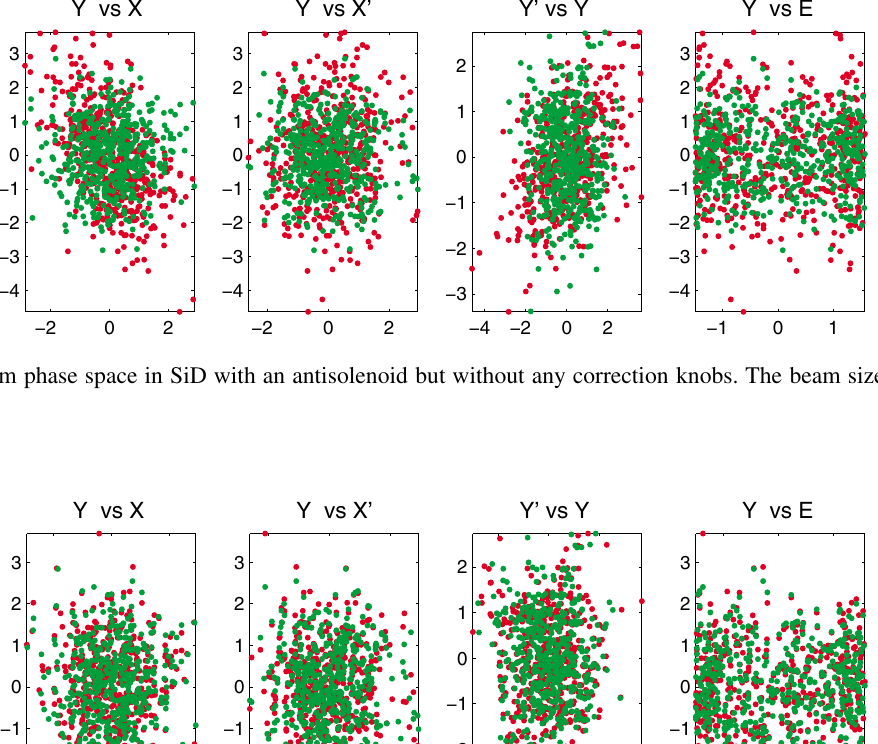
FIG. 16. (Color) Beam phase space in SiD with an antisolenoid and with additional correction knobs. The beam size is (cid:3) (cid:3) 1 : 003 . =(cid:3) 1 : 00 , (cid:3) y y 0